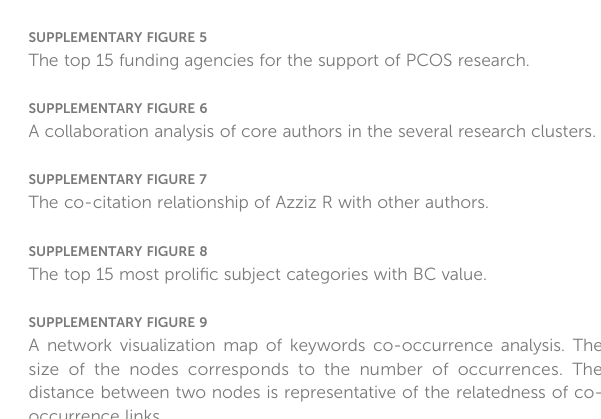
SUPPLEMENTARY FIGURE 2 The visualization of cooperative relationships among countries/regions. Thicker lines represent stronger cooperation. SUPPLEMENTARY FIGURE 3 Country co-authorship overlay visualization map generated by VOSviewer. The size of each note represents the number of publications. Collaboration between the two countries becomes more close as the line thickens, which is measured by TLS. The color of each note is based on the average appearing year (AAY) of the country, as shown by the gradient at the bottom right. SUPPLEMENTARY FIGURE 4 The top 15 most proli fi c institutions. SUPPLEMENTARY FIGURE 5 The top 15 funding agencies for the support of PCOS research. SUPPLEMENTARY FIGURE 6 A collaboration analysis of core authors in the several research clusters. SUPPLEMENTARY FIGURE 7 The co-citation relationship of Azziz R with other authors. SUPPLEMENTARY FIGURE 8 The top 15 most proli fi c subject categories with BC value. SUPPLEMENTARY FIGURE 9 A network visualization map of keywords co-occurrence analysis. The size of the nodes corresponds to the number of occurrences. The distance between two nodes is representative of the relatedness of co- occurrence links. SUPPLEMENTARY TABLE 1 Top 20 high-yield countries/regions related to PCOS research. Rank, based on the number of total